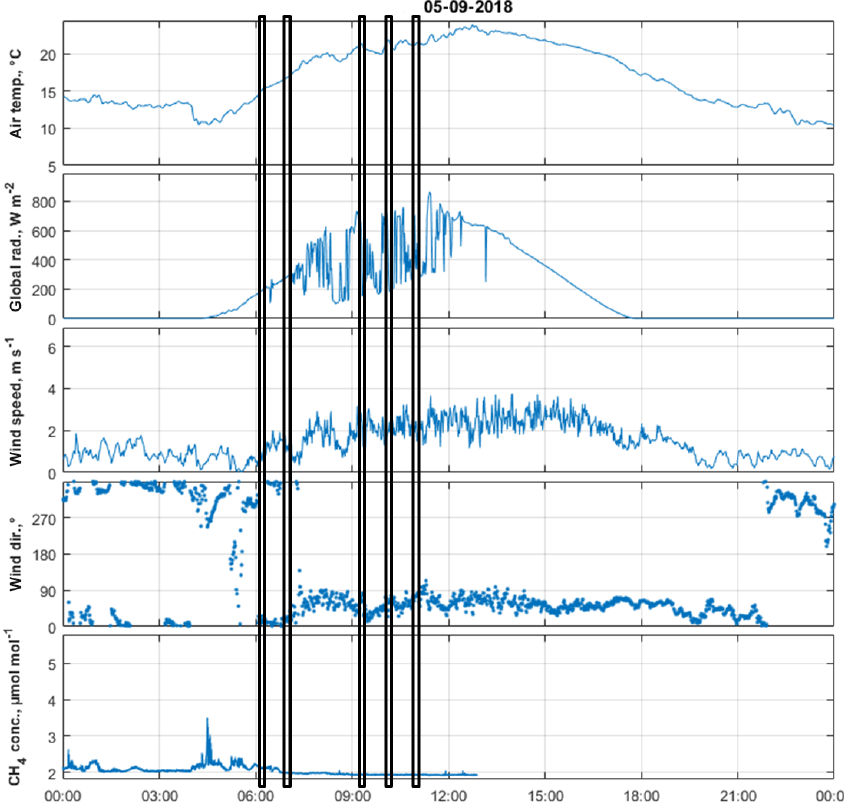
Figure 6. Diurnal course of the main meteorological parameters air temperature, global radiation, wind speed, wind direction and methane concentration (closed-path Los Gatos sensor) recorded at the meteorological mast at Zarnekow on 5 September 2018. The times of the quadrocopter air sampling are indicated by vertical boxes.